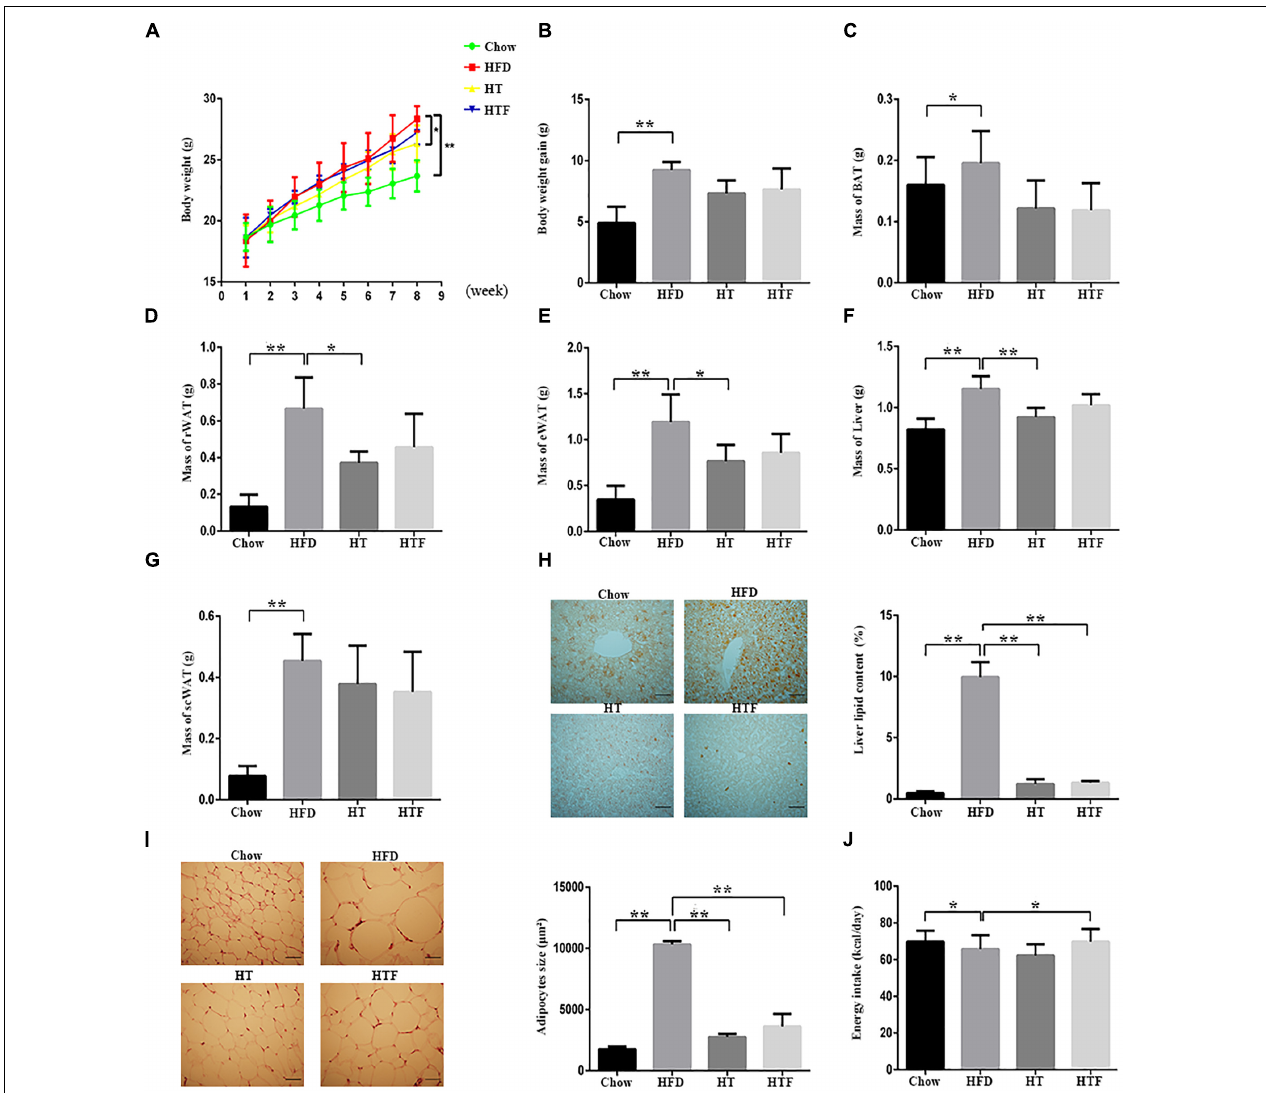
FIGURE 1 | HT and HTF reduces body weight and fat accumulation in HFD-fed mice. HFD-fed mice were treated daily with HT (50 mg/ kg) or HTF (100 mg/1 ml) by intragastric gavage for 8 weeks ( n = 7 for each group). Effects of HT and HTF treatment on body weight (A) body weight gain (B) brown fat (C) perirenal fat (D) epididymal fat (E) liver weight (F) subcutaneous fat (G) oil red O staining (H) subcutaneous adipocyte size (I) and energy intake (J) , are shown. In (H) , Liver lipid content was assessed using the Image J software. Scale bar, 50 µ m. In (I) , adipocyte size was estimated using the Image J software (lower panel). Scale bar, 50 µ m. Graph bars with statistically significant results ( P ≤ 0.05) based on one-way ANOVA analysis followed by Tukey’s honest significant difference post hoc tests. Data are shown as mean ± s.e.m ( ∗ P ≤ 0.05, ∗∗ P ≤